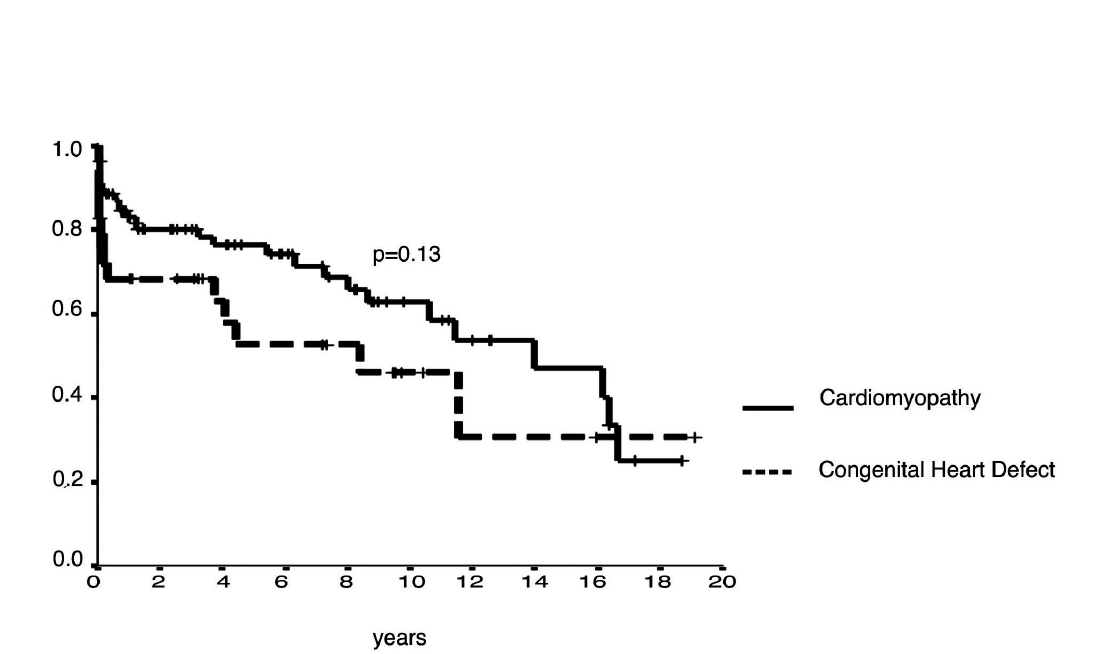
Fig. 3 - Comparative graph between survival with Congenital Heart and Cardiomyopathy after Heart Transplant. P=0.13 with Cox proportional regression analysis.